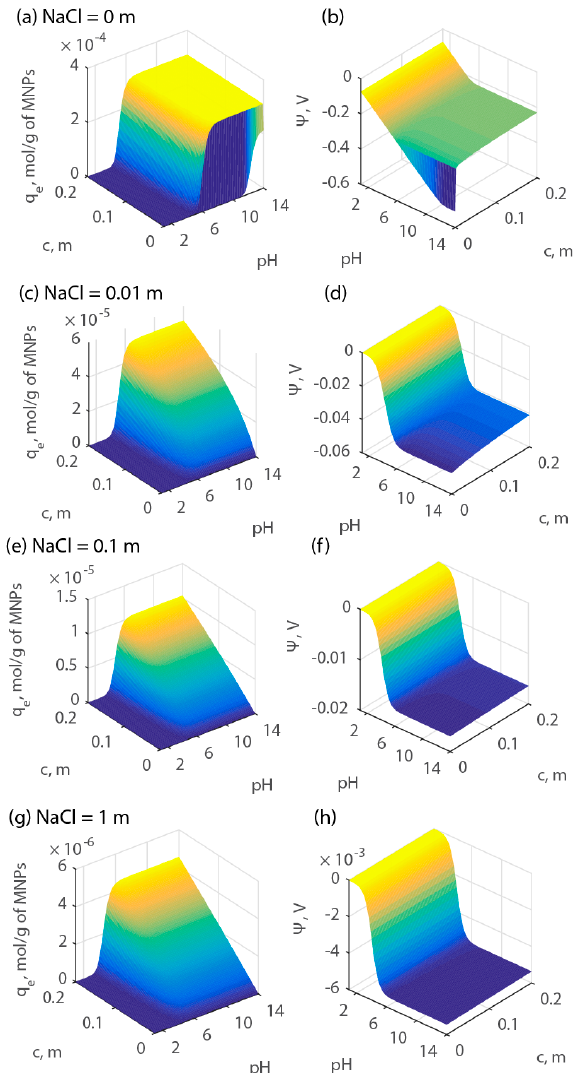
Figure 10. Adsorption capacity ( q e ) and surface potential as a function of pH and cation concentration at various electrolyte concentrations. Parts ( a ), ( c ), ( e ), and ( g ) report the adsorption capacity of protons. Parts ( b ), ( d ), ( f ), and ( h ) report the adsorption capacity of calcium.